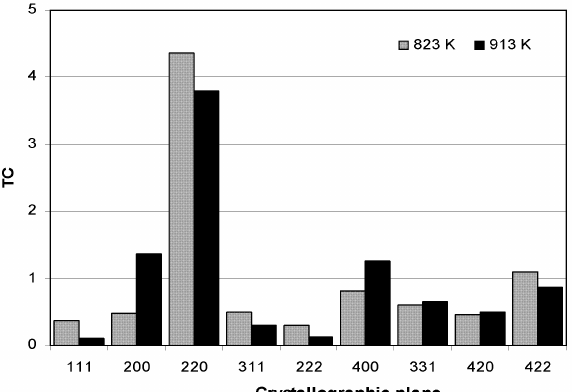
Figure 3. TC values of individual diffraction planes of Al-4 vol. % Al 4 C 3 material annealed at 823 K and 913 K.